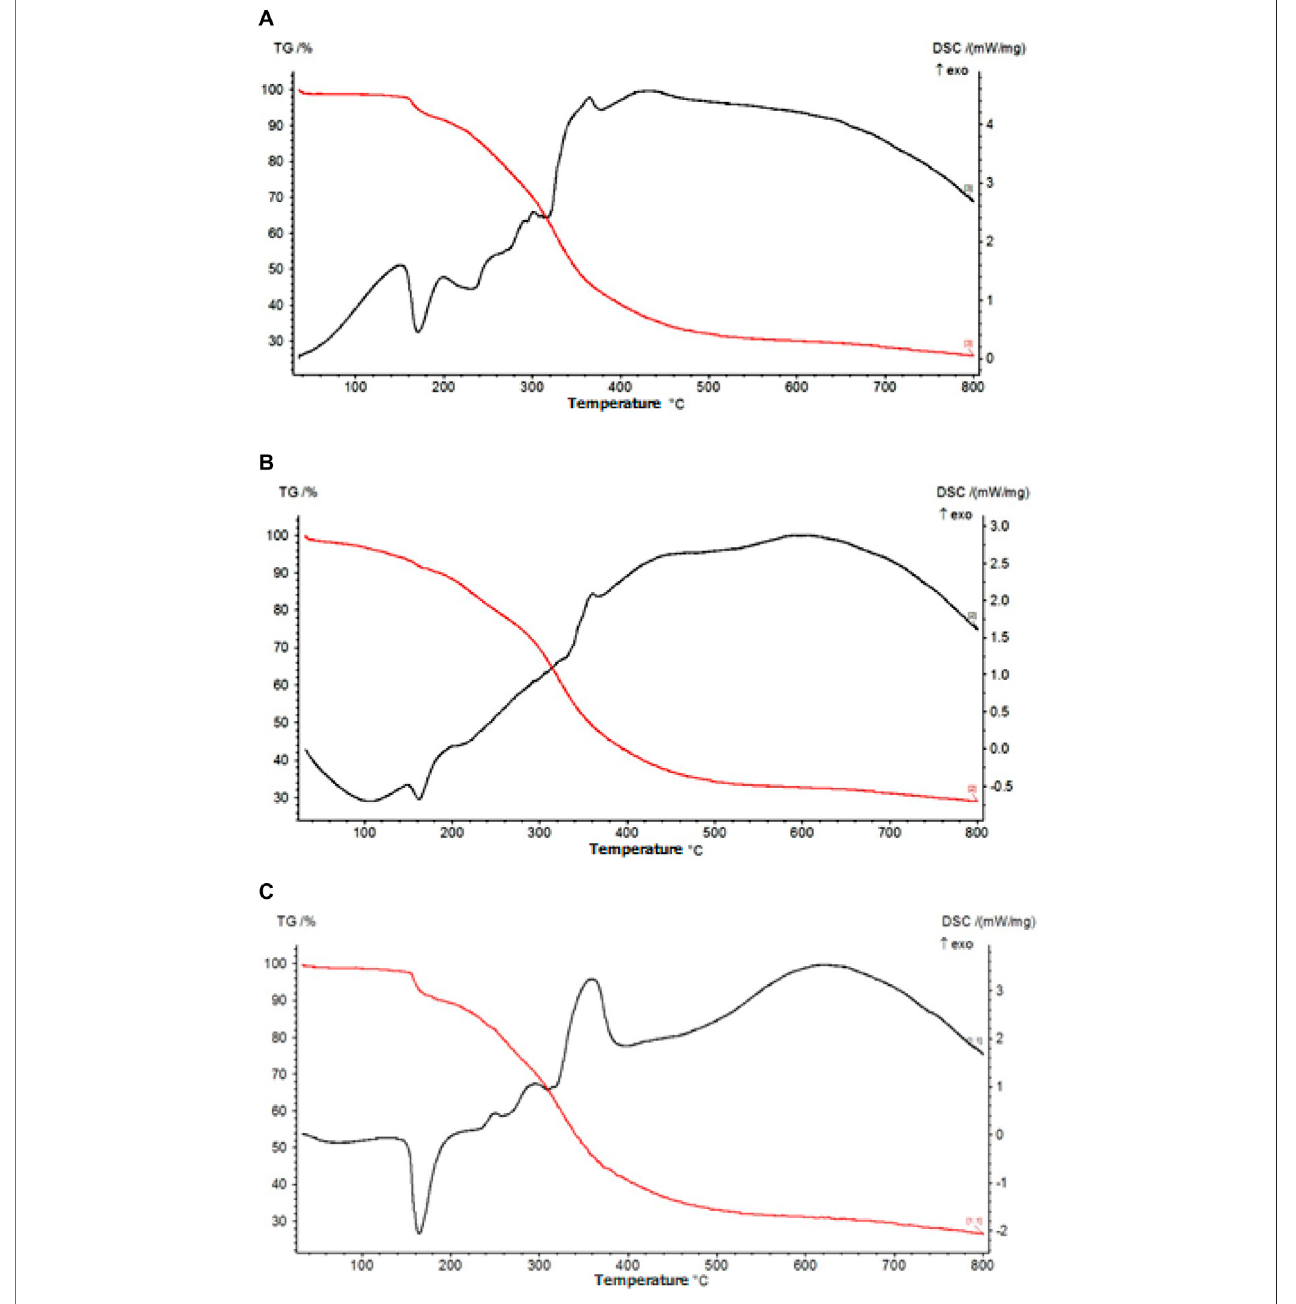
FIGURE 4 | TG and DSC thermograms of the fi lms (A) %5 AA, (B) %7,5 AA, (C) %10 AA